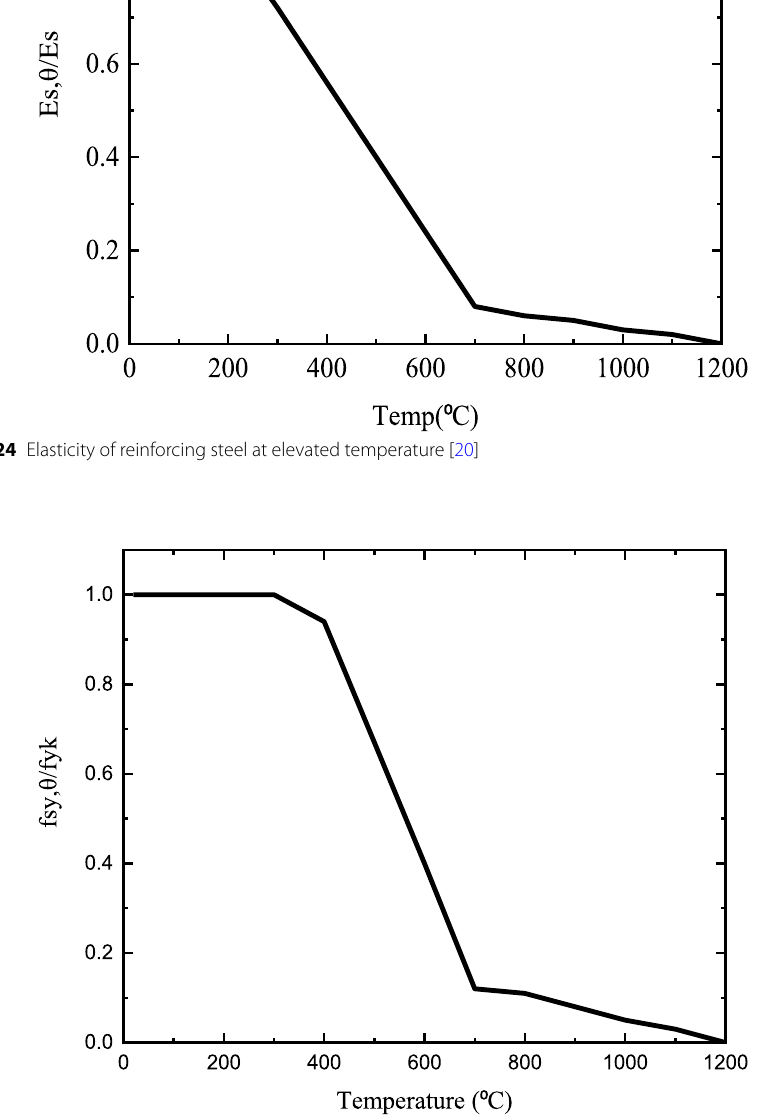
Fig. 25 Yield strength of reinforcing steel at elevated temperature